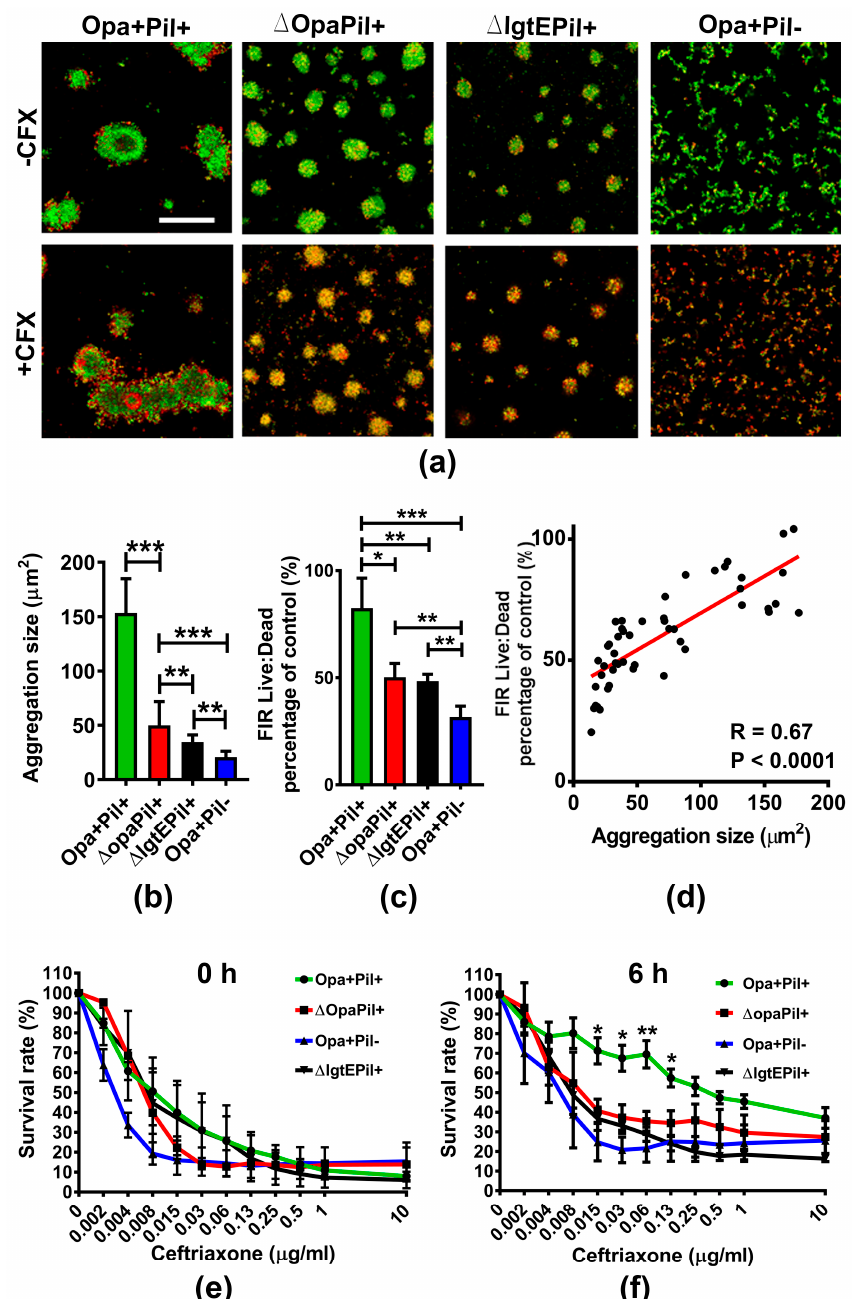
Figure 2. Comparison of survival rate and distribution in GC aggregates that lack Opa or Pili or express truncated lipooligosaccharides (LOS) under ceftriaxone treatment. MS11Opa+Pil+, MS11 ∆ OpaPil+, MS11Opa+Pil-, or MS11 Δ LgtEPil+ were allowed to aggregate for 6 h. ( a ) Pre-aggregated GC were incubated with 1 µg/mL ceftriaxone (+CFX) or mock treated (-CFX) for 2 h, stained with Live/Dead BacLight stain for visualizing live (Green) and dead (Red) GC, and analyzed using a confocal fluorescence microscope. Scale bar: 50 µm. ( b ) The sizes of GC aggregates were quantified by the area of each aggregate. ( c ) The live to dead GC ratios were quantified by the fluorescence intensity ratio (FIR) of green to red staining. The average size of aggregation and live to dead ratio (±SD) were obtained from >40 images of three independent experiments. ( d ) The relation between GC aggregation and their susceptibility to antibiotics was analyzed by plotting the sizes of GC aggregates versus their survival rates and linear regression. ( e , f ) 0 h non- and 6 h pre-aggregated GC were incubated with serial concentrations of ceftriaxone for 24 h. The ATP production under each condition was measured. Shown are the average values (±SD) obtained from three independent experiments. *** p < 0.001; ** p < 0.01; * p < 0.05.